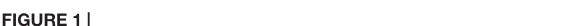
FIGURE 1 | The top row shows results for neutral facial expressions, the second row for angry and the third row for happy facial expressions. ( B , left panel) The scalp distribution of the lateralized N170 from 160–200 ms. The contralateral activity was maximal at location P7/P8. ( B , right panel) The difference waves for each facial expression and task. The orange region highlights the N170 interval where we found a larger amplitude for angry faces in the gender task, but not in the pixel task. (C) Scalp topographies of the differences between